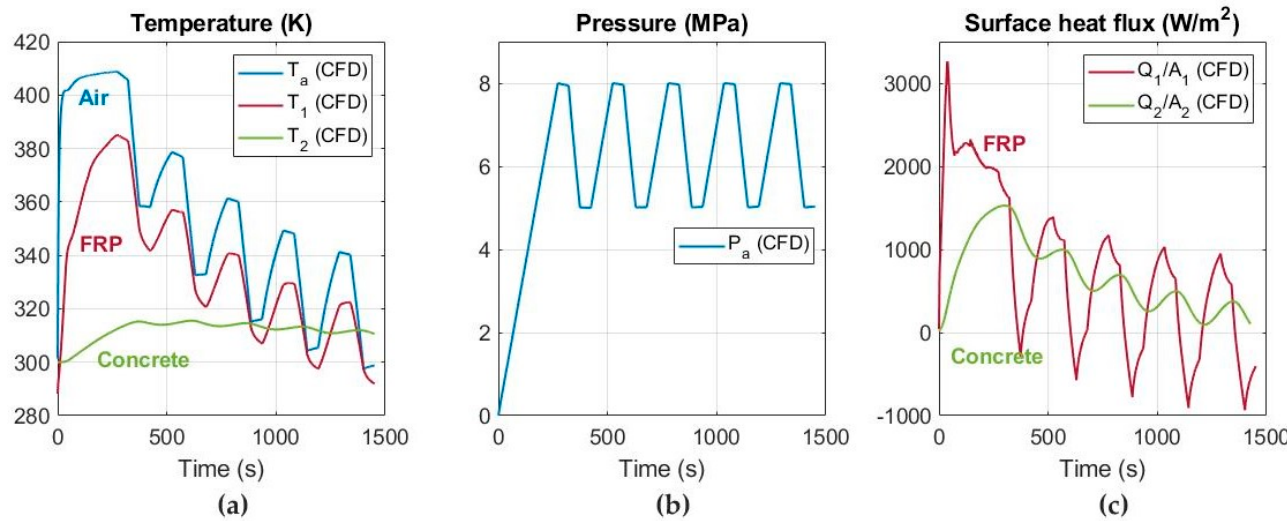
Figure 9. Numerical model results for 5 charging and discharging cycles considering FRP as sealing layer. ( a ) Temperature of air, FRP and concrete lining; ( b ) Air pressure; ( c ) Surface heat flux of FRP and concrete lining.